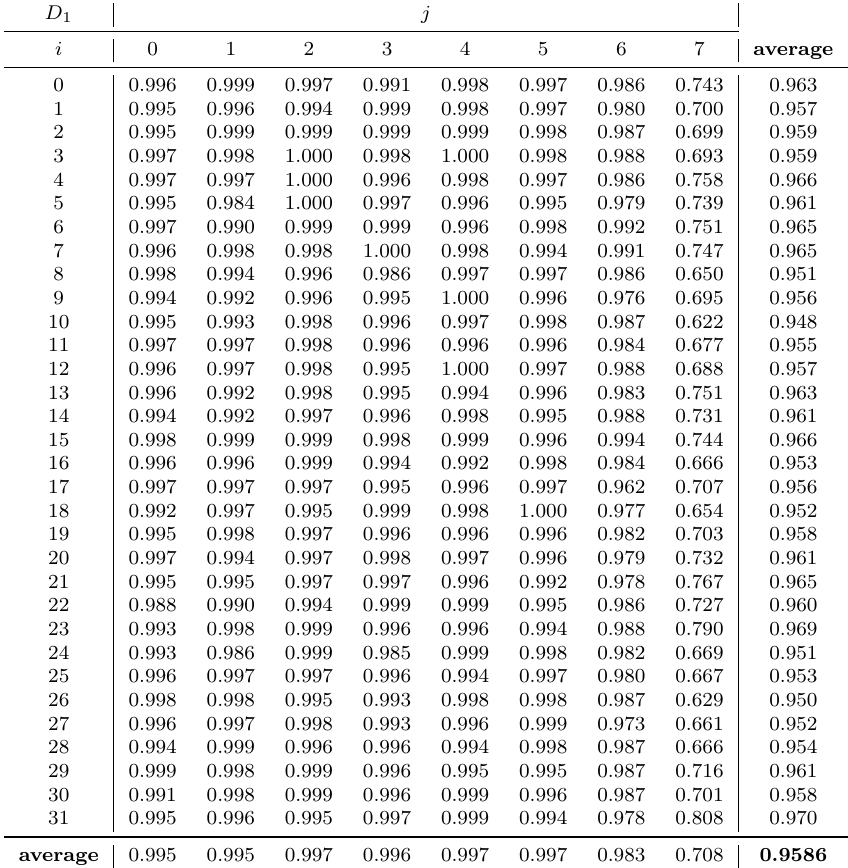
Table 14: Empirical probability to recover the message bit m [8 i + j ] from a single trace using POL2MSG() . Average results for 1K traces from device D 3 . D